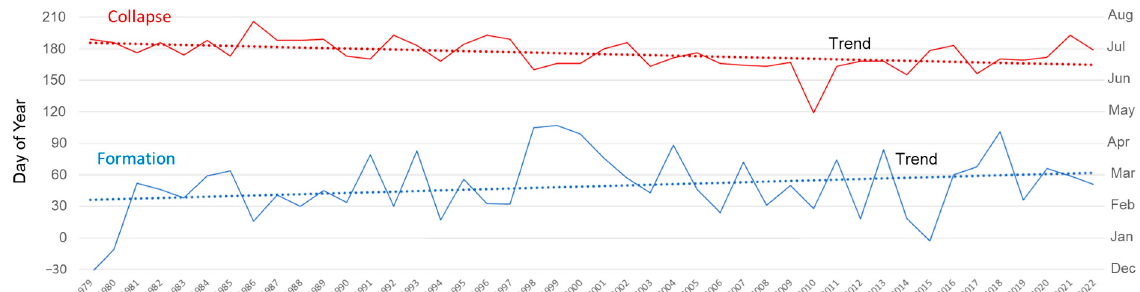
Figure 7. Formation and collapse of the Lancaster Sound ice arch from 1979 to 2022. Formation date of the ice arch is more variable than the collapse date. Ice arch formation is trending toward later dates, while collapse of the structure is trending toward earlier dates. The formation trend is statistically weak ( p -value = 0.1000), but the collapse trend is statistically significant ( p -value = 0.0031).